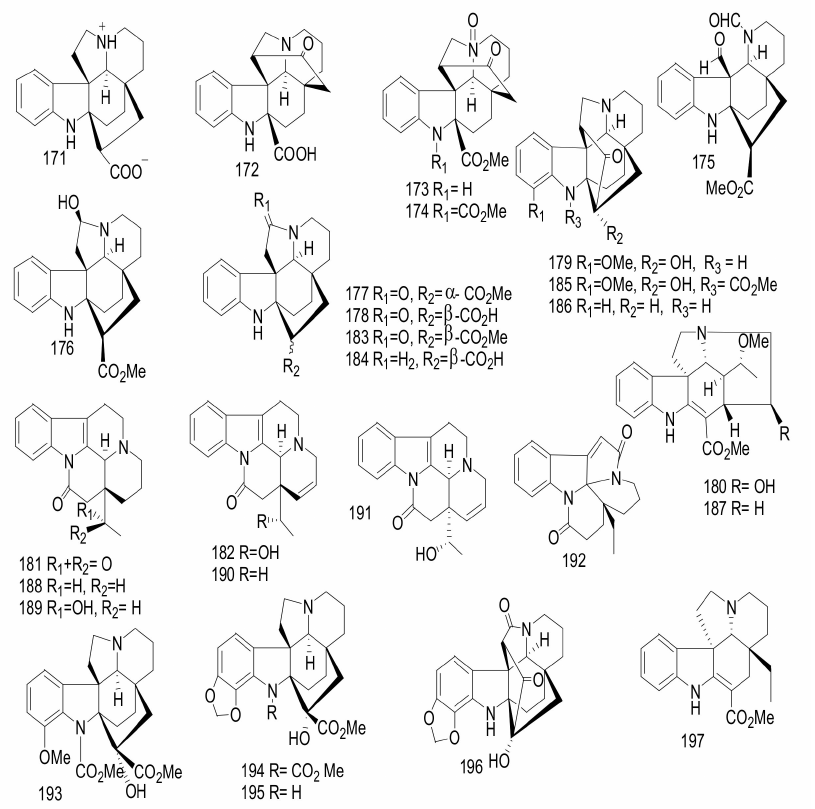
Figure 19. Compounds 171 – 197